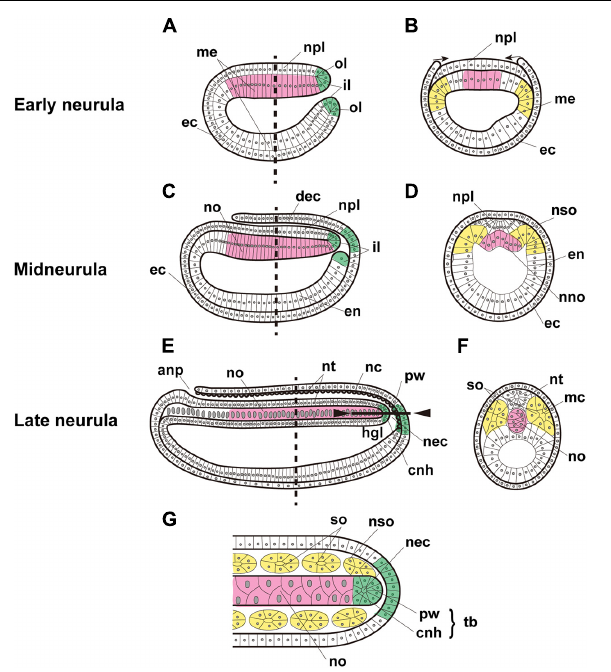
FIGURE 1 | Expected expression of Brachyury genes in the notochord (magenta), somites (yellow), and tail bud (green) of amphioxus embryos. Early neurula, (A) sagittal section, and (B) cross section at the location shown by the dashed line in panel (A) . Arrows indicate the migration of ectoderm across the neural plate. Midneurula, (C) sagittal section, and (D) cross section at the level shown by the dashed line in panel (C) . Cross section showing somites and notochord beginning to form. Late neurula, (E) sagittal section, (F) cross section at the level shown by the dashed line in panel (E) , and (G) frontal section of the region indicated by the solid line between arrowheads in panel (E) . In alphabetical order, abbreviations are as follows: anp, anterior neuropore; cnh, chordoneural hinge; dec, dorsal ectoderm; ec, ectoderm; en, endoderm; hgl, hindgut lumen; il, inner lip of blastopore; mc, myocoel; me, mesendoderm; nc, neurocoel; nec, neurenteric canal; nno, nascent notochord; no, notochord; npl, neural plate; nso, nascent somite; nt, neural tube; ol, outer lip of blastopore; pw, posterior wall of neurenteric canal; so, somite; tb, tail bud. The original drawing of embryos by Schubert et al. (2001) is